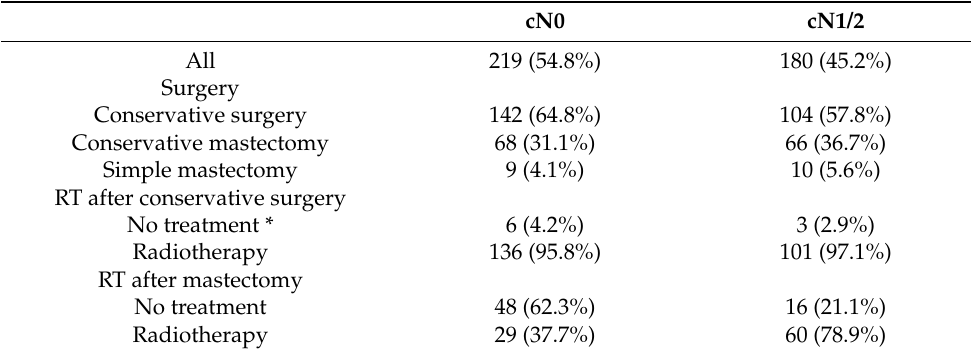
Table 3. Surgical treatment and adjuvant